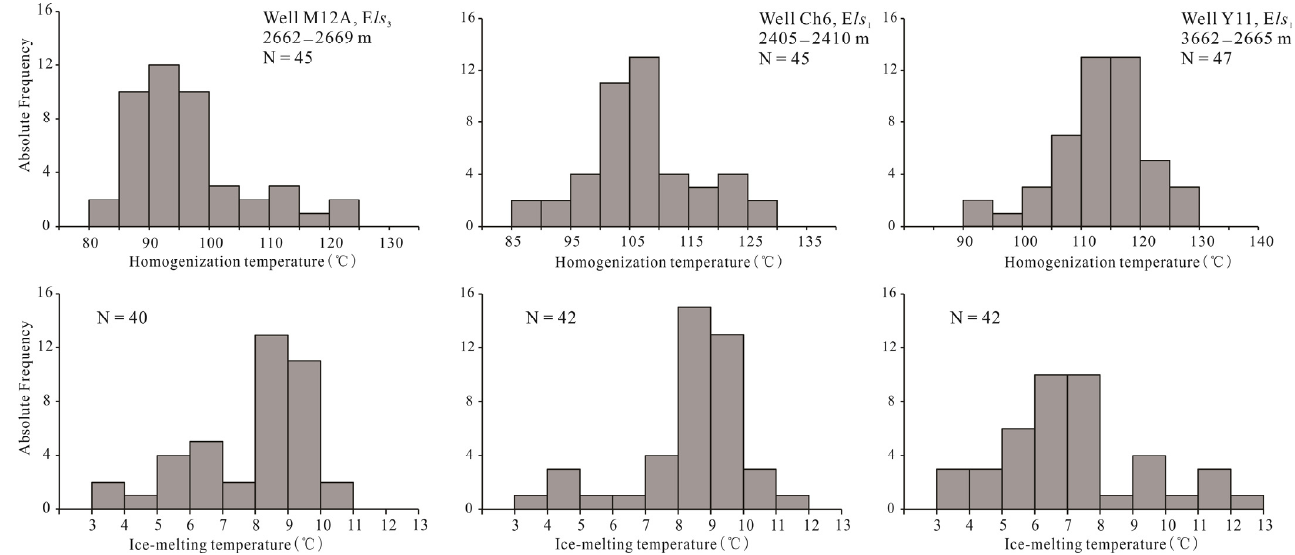
Figure 10. The histograms of the homogenization temperature (Th) and the ice-melting temperatures (Tm).